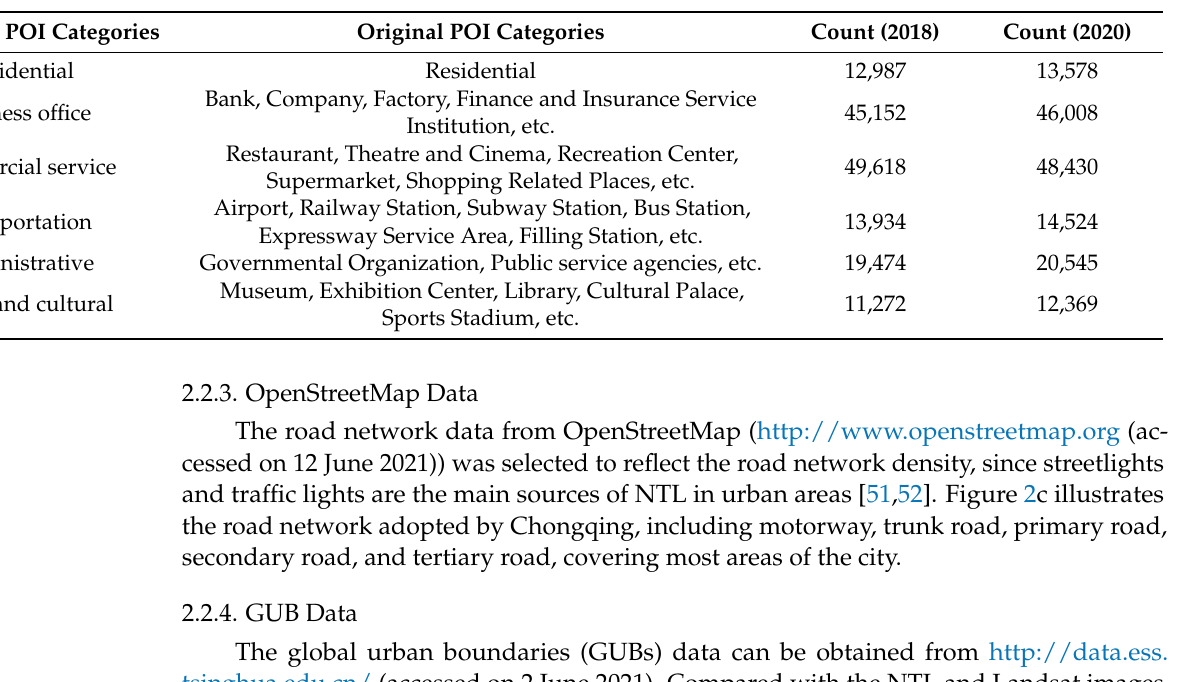
Table 1. The description of POI data